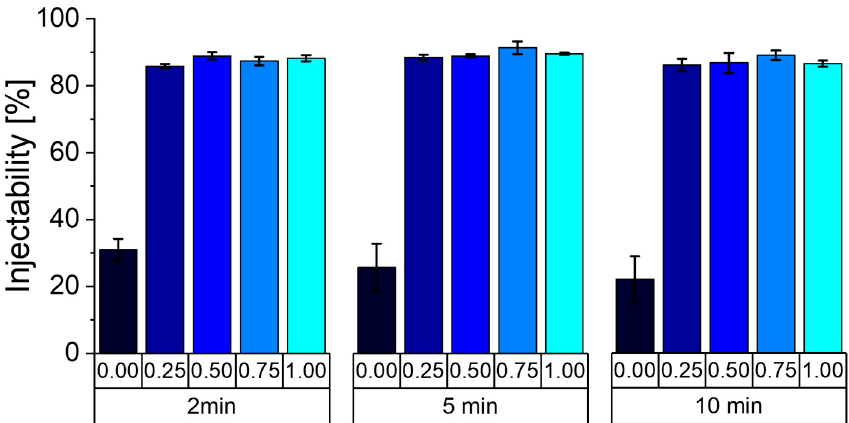
Figure 4. Injectability of all five paste formulations (Phy_0.00 – Phy_1.00) 2, 5 and 10 min after the powder and liquid mixing. Every sample has been prepared three times, and the error bars represent the standard deviation.